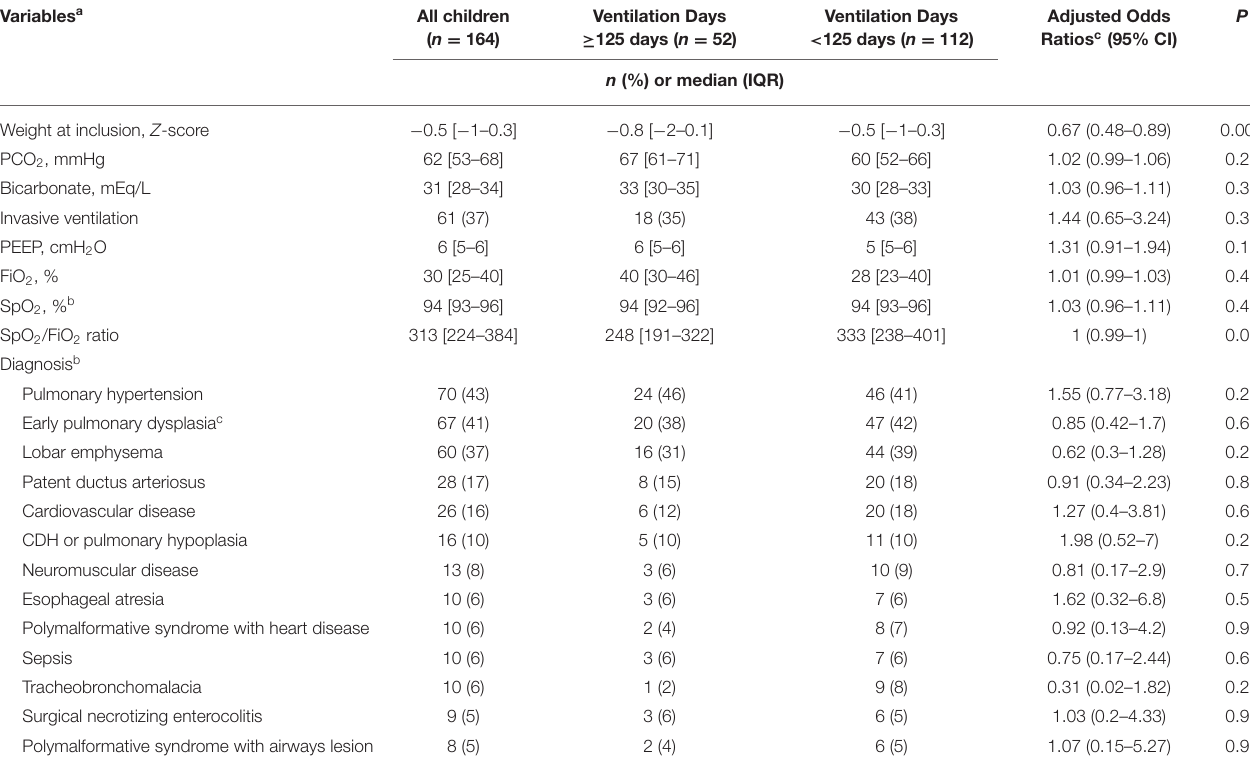
TABLE 2 | Characteristics at